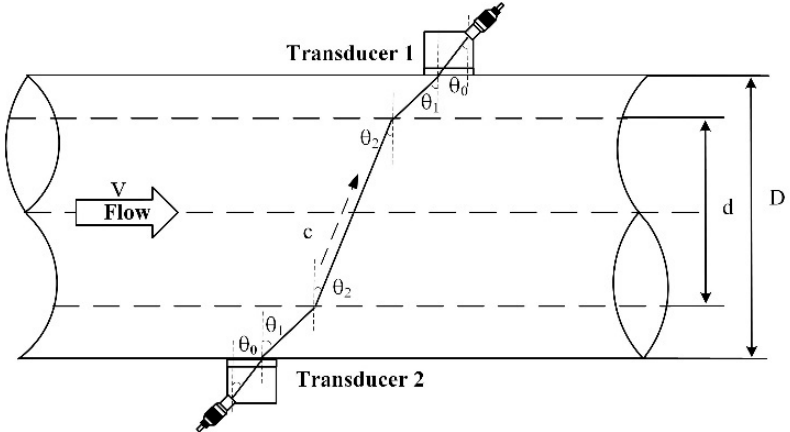
Figure 1. Schematic diagram of time difference measurement.